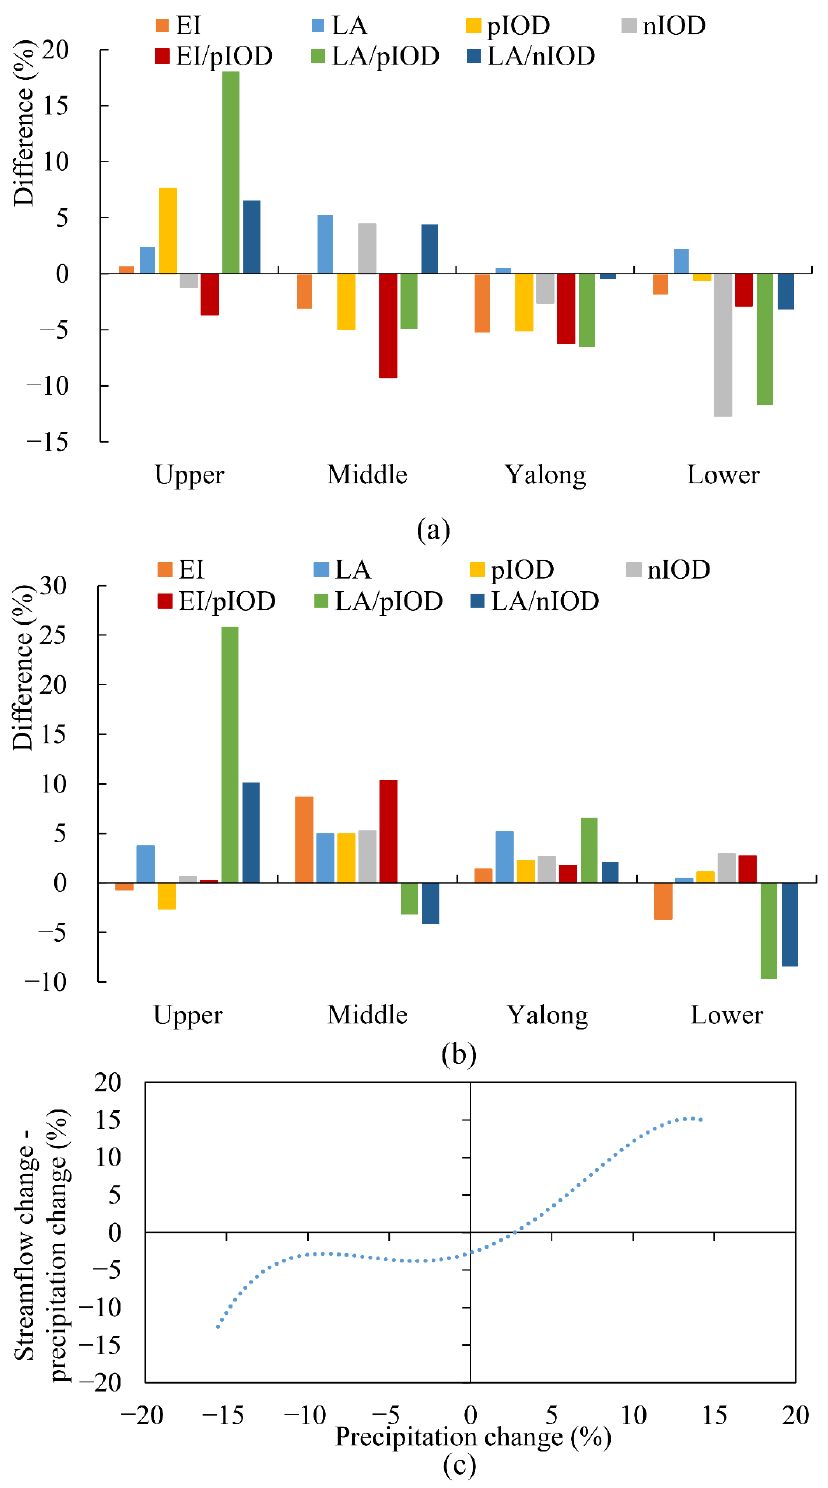
Figure 12. Annual precipitation in the different sub-basins and the entire Jinsha River Basin relative to neutral years in ( a ) developing years and ( b ) decaying years. ( c ) Percentage change in streamflow minus the percentage change in precipitation as a function of the percentage change in precipitation in the Jinsha River Basin.